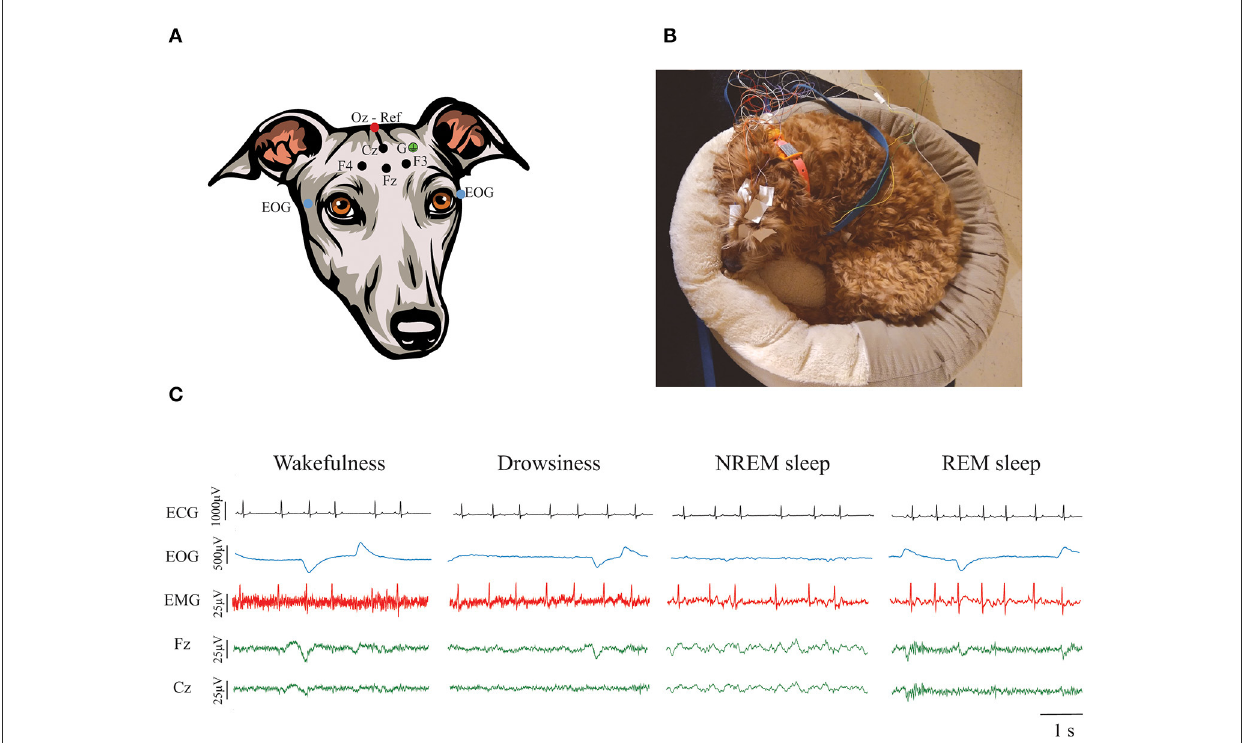
FIGURE1 Polysomnographic recordings in dogs. (A) Electrode locations. Four active EEG electrodes were placed over the midline, left and right frontal areas (Fz, F3, and F4, respectively), and over the vertex (Cz). Those electrodes are represented with a black dot. A reference electrode was placed over the external occipital protuberance (Oz) and it is represented with a red dot. Bipolar EOG signal was recorded by placing two electrodes on the left and right zygomatic arch next to the lateral canthus of each eye (blue dots). A ground electrode (G) was placed over the left temporal muscles (green dot). EMG and ECG were also recorded but it is not shown in the figure. (B) Picture of a dog undergoing a polysomnographic recording using their own bed. (C) Representative ECG, EOG, EMG, and EEG signals during wakefulness, drowsiness, NREM, and REM sleep. Contamination of the ECG can be observed in the EMG